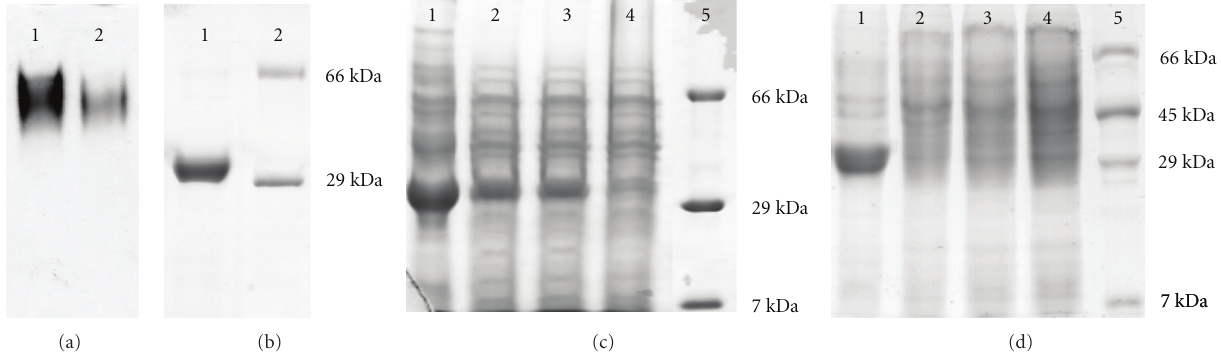
Figure 1: Polyacrylamide gel electrophoresis of SBL samples. (a) Product from a ffi nity chromatography purification procedure in silver- stained nondenaturing PAGE at pH 8 and with a polyacrylamide concentration of 7.5%. Lane 1 : commercially obtained SBL (Sigma Chemical Co.), lane 2 : product from a ffi nity purification. (b) The same SBL fraction in silver-stained SDS-PAGE. Lane 1 : final SBL purification fraction; lane 2 : molecular weight markers. (c) The same SBL fraction in Coomassie blue-stained SDS-PAGE after incubation with B. japonicum USDA 110 cells and centrifugation. Cells were incubated with 10 μ g ml − 1 SBL for 12hours and centrifuged at 10 . 000 × g for 20minutes without further processing ( lane 1 ), or after three cycles of resuspension in di ff erent solutions, agitation at 4 ◦ C 10 minutes and centrifugation at 10 . 000 × g for 20 minutes. Lane 2 : resuspension in low salts bu ff er, containing 3.0 mM KCl, 1.5mM KH 2 PO 4 , 68.0 mM NaCl, and 9.0 mM NaH 2 PO 4 ; lane 3 : resuspension in 1M NaCl; lane 4 : resuspension in PBS containing 1 M galactose; lane 5 : molecular weight markers. (d) Comparison of the protein profiles from USDA 110 and the mutant Δ P22 after incubation with or without 10 μ g ml − 1 SBL for 12hours followed by centrifugation at 10 . 000 × g for 20 minutes. Lane 1 : USDA 110 with SBL. Lane 2 : USDA 110 without SBL. Lane 3 : Δ P22 with SBL. Lane 4 : Δ P22 without SBL. Lane 5 : Molecular weigh